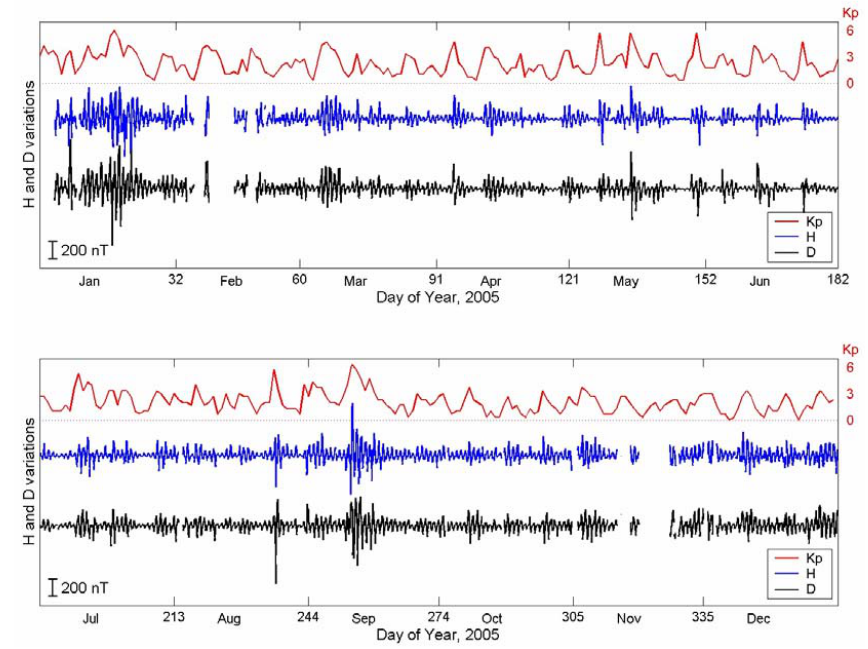
Fig. 2. Hourly values of the variations of the H and D components during 2005, with the daily averages of the K p index.